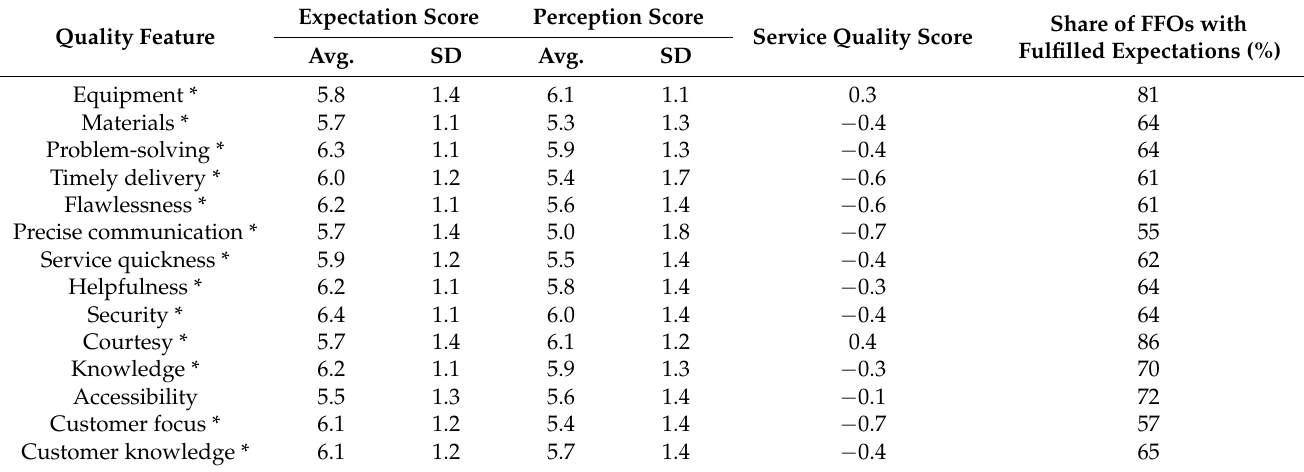
Table 2. FFOs’ average expectation score, perception score, and service quality score for the 14 quality features. The proportion (%) of FFOs who had their expectations fulfilled (service quality score ≥ 0) is also shown for each quality feature. Paired sample t -tests showed significant differences between expectations and perception scores on all but one feature (* indicates significance at p <